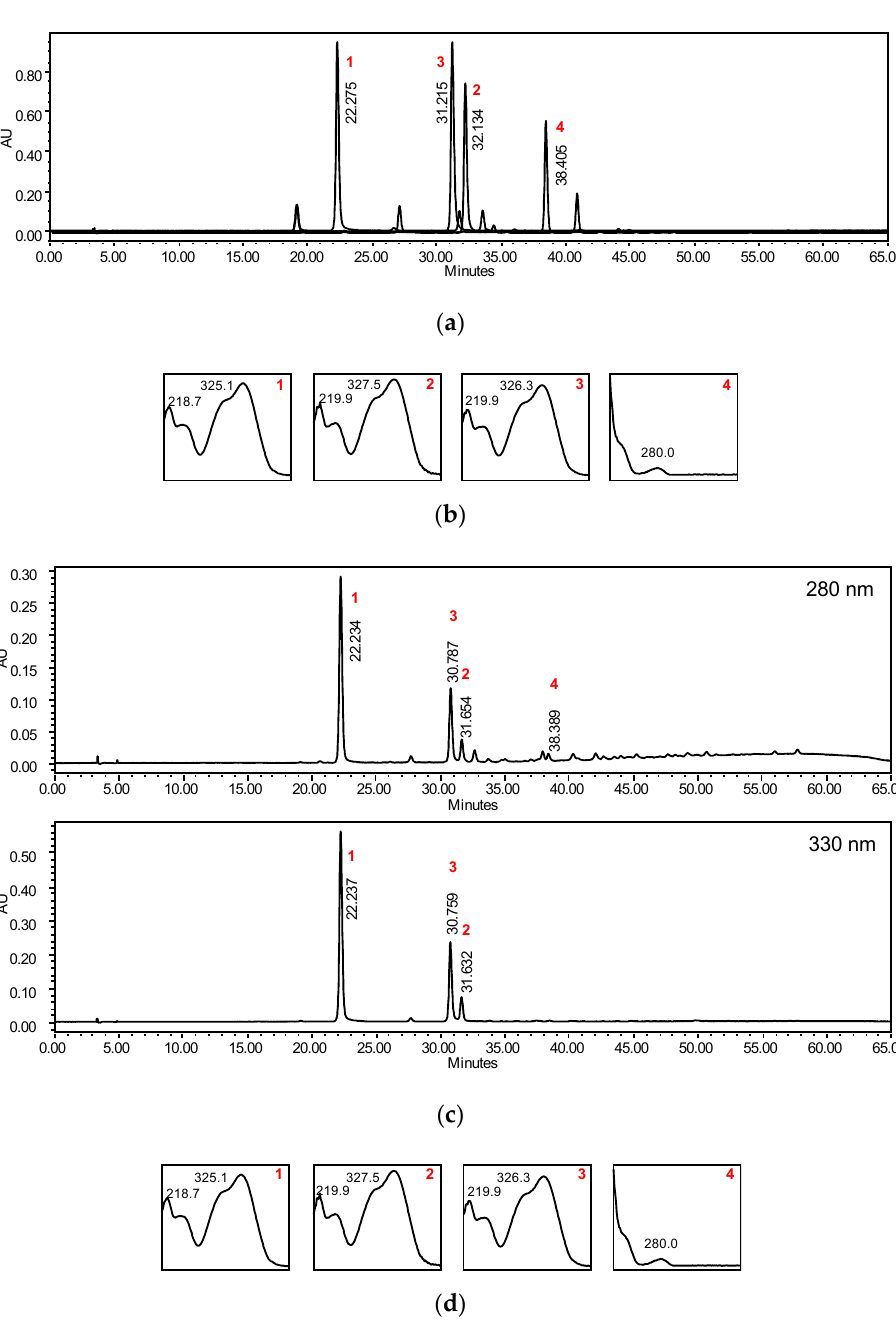
Figure 4. HPLC chromatogram of standard compounds, 3-O-caffeoyl quinic acid ( 1 ), 4-O-caffeyl quinic acid ( 2 ), 5-O-caffeoyl quinic acid ( 3 ), and epi-catechin ( 4 ); 1-3 extracted at 330 nm, 4 extracted at 280 nm ( a ), UV spectra of standard compounds 1 - 4 ( b ), HPLC chromatograms of BK(B) extract ( c ), and UV spectra of compounds 1 - 4 in BK(B) extract ( d ).